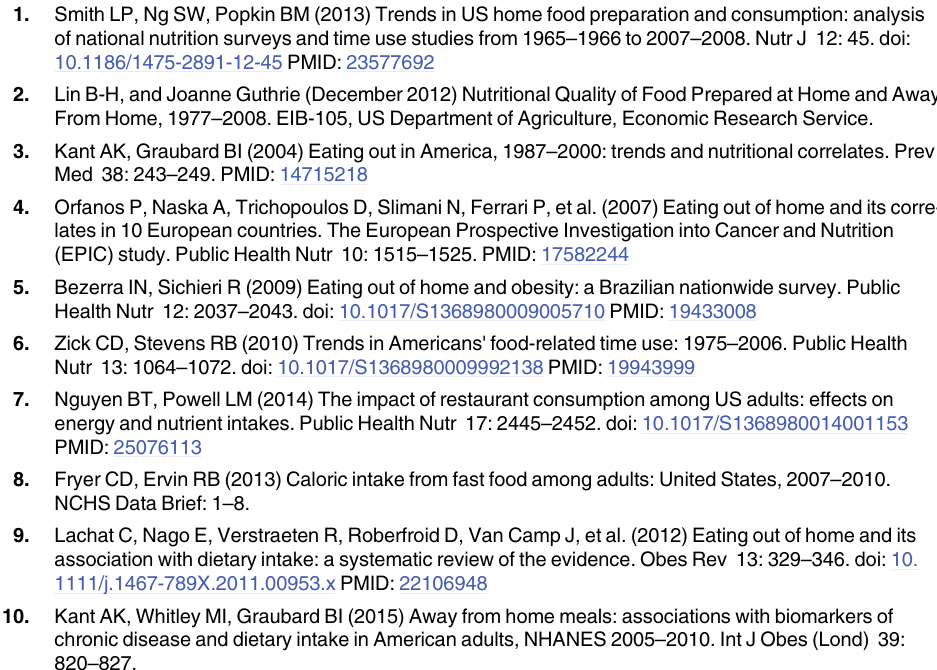
S4 Table. Pooled HRs (95% CIs) of T2D according to frequencies of midday and evening MPAH by further adjusting for dietary factors. S5 Table. Stratified analysis of HRs (95% CIs) of T2D according to frequencies of consum- ing MPAH. S6 Table. Sensitivity analysis on associations of MPAH and T2D risk. S7 Table. Sensitivity analysis on associations between frequencies of MPAH and T2D risk by further adjusting for other socioeconomic variables available in the